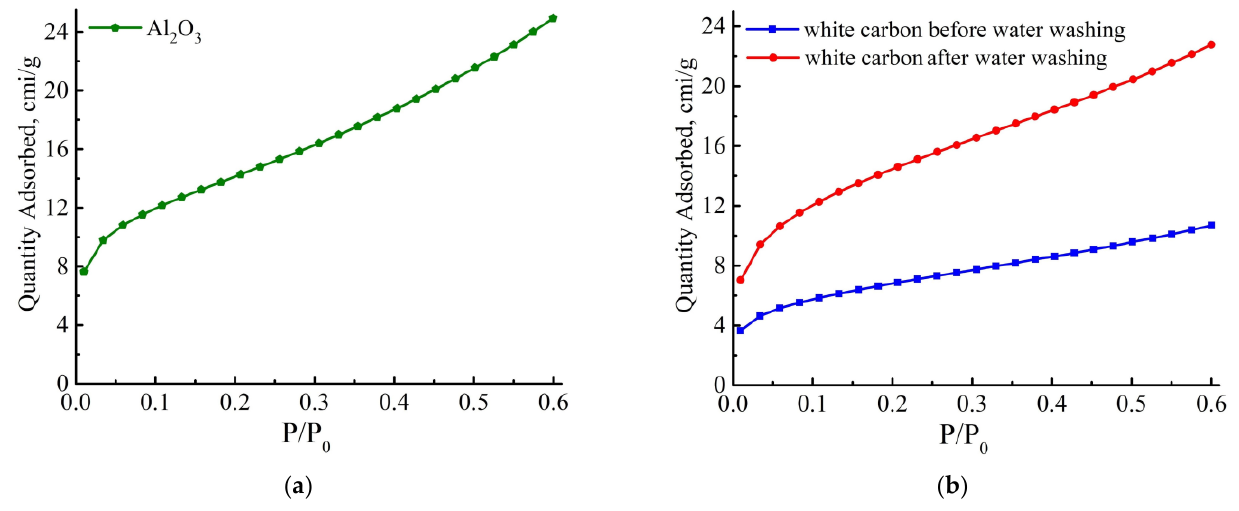
as for the white carbon samples before and after water washing.